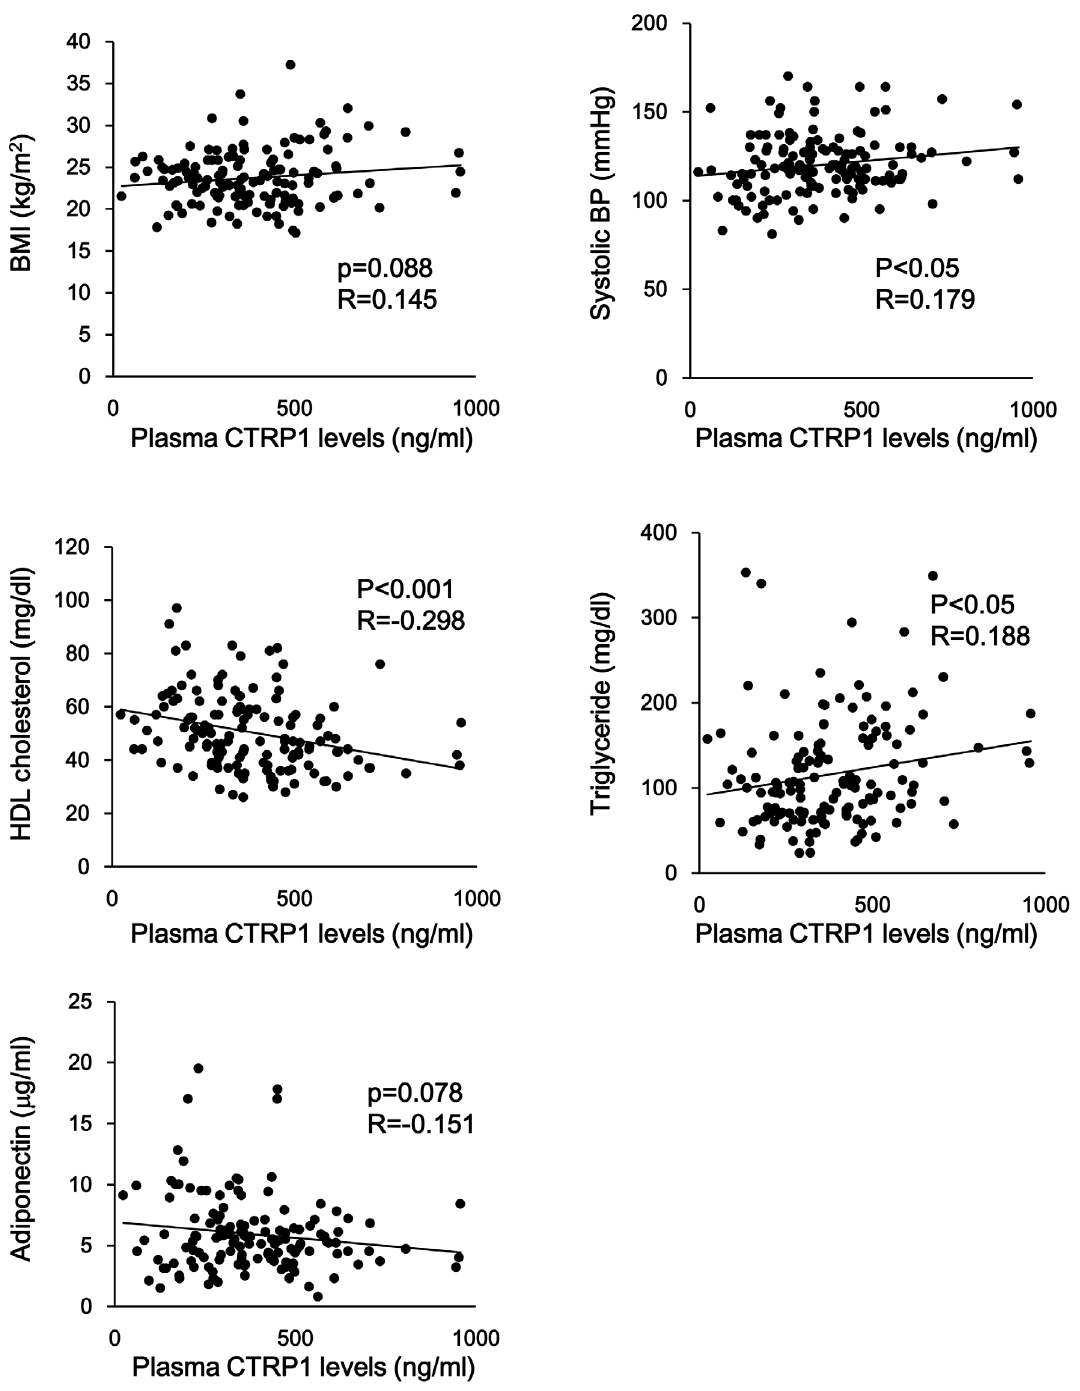
Figure 2. Correlation between plasma CTRP1 levels and conventional risk factors. Correlation analyses between plasma CTRP1 levels and risk factors, including body mass index (BMI), systolic blood pressure (BP), high density lipoprotein (HDL) cholesterol, triglyceride and adiponectin levels were evaluated.